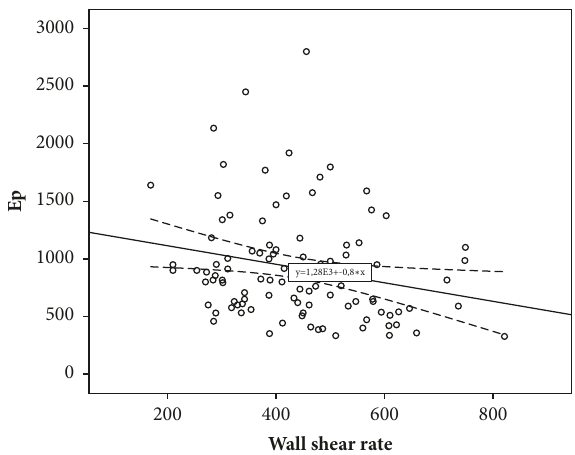
Figure 3: The relationship between wall shear rate and carotid distensibility.